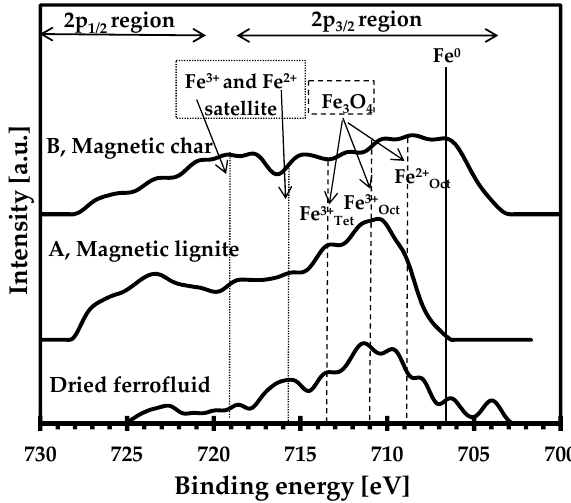
Figure 6. Background-subtracted Fe 2p XPS spectra of the sorbents (magnetic lignite and magnetic char) and dried ferrofluid. The multiple peaks of Fe 3+ and Fe 2+ in the Fe 2p 3/2 region were labelled in the graph as described by [30,31].